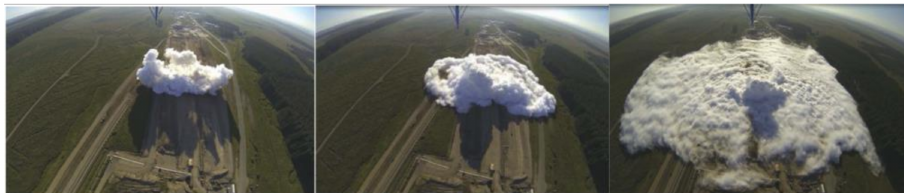
Figure 3. The visible cloud behavior after the rupture; from left to right, at 10, 30 and 120 s from the break (This figures were published from International Journal of Greenhouse Gas Control , Ah- mad et al. [40], Copyright Elsevier, 2015).